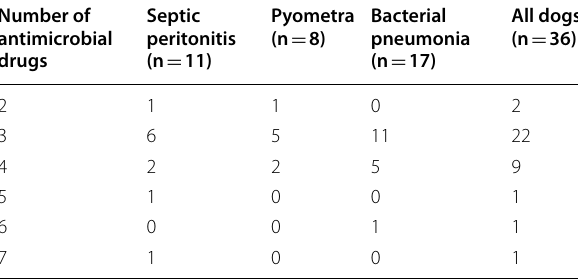
Table 2 Number of antimicrobial drugs per dog based on disease types prescribed during the study duration Number of